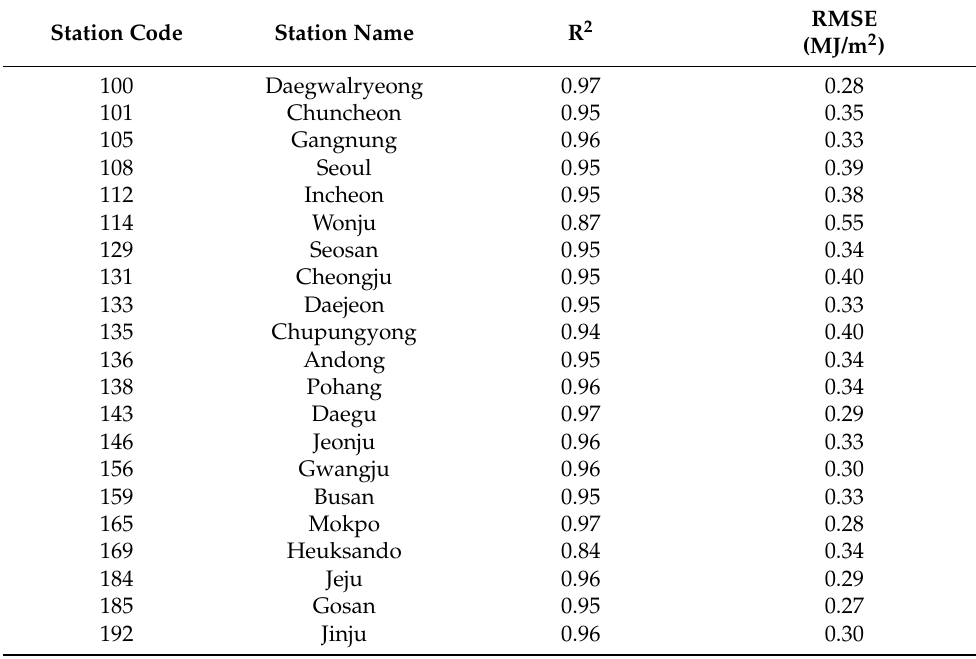
Table 3. Comparison of ET o computed by observed and estimated R s